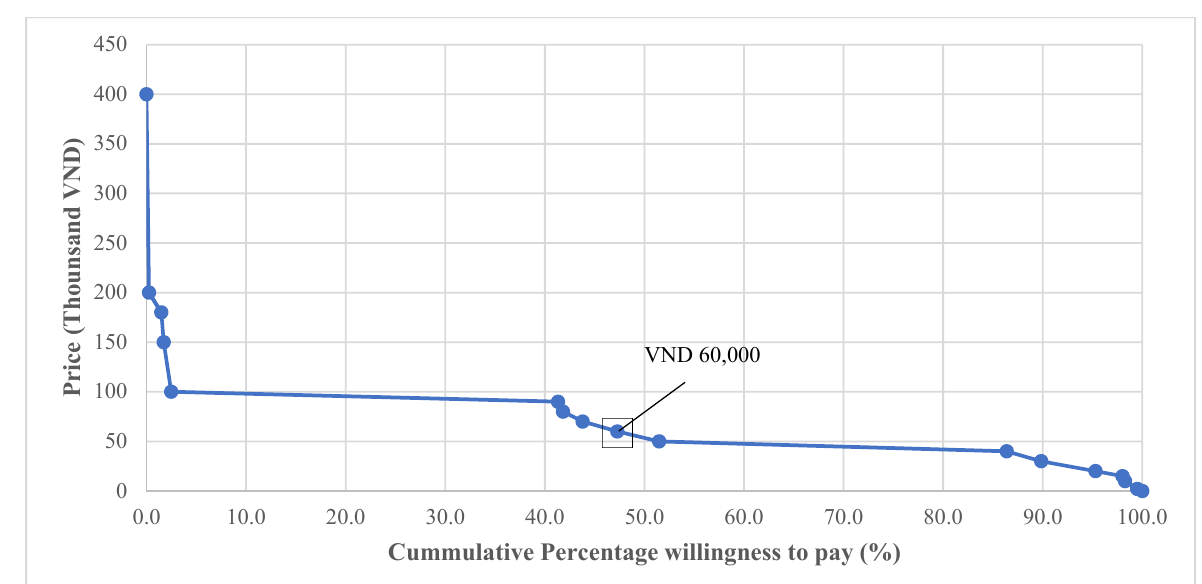
Figure 1. Cumulative percentage of the amount of WTP.